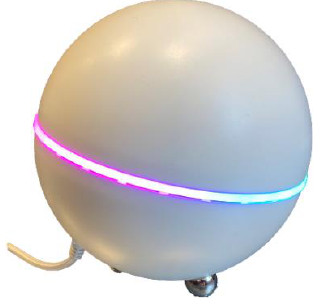
Figure 9. Smart-home controller Athom Homey Pro 2.0.